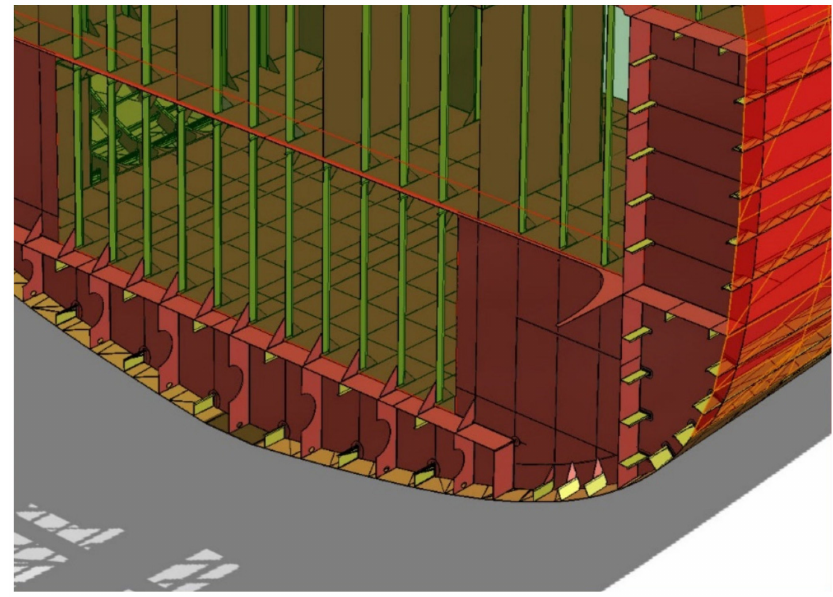
Figure 8. FEM analysis of a warship